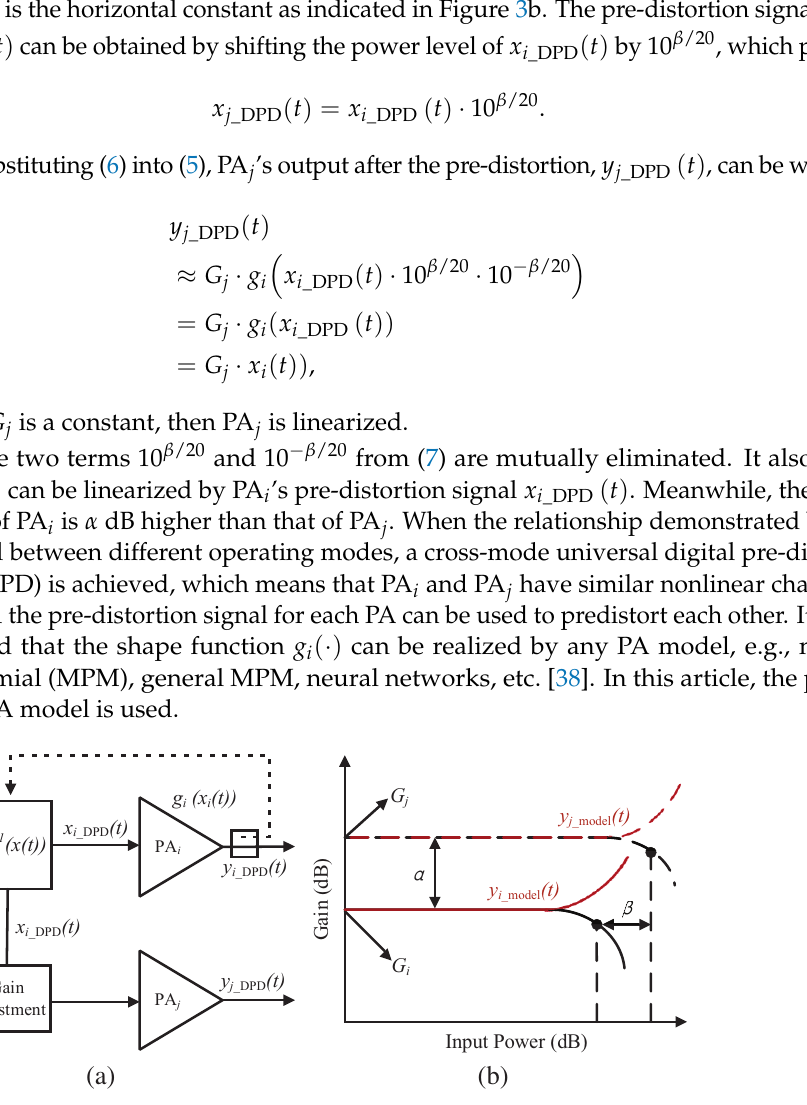
Figure 3. ( a ) Simulated circuit example used to illustrate theoretical principle of the proposed CMUDPD technique. ( b ) Gain curve versus input power in different PA operation